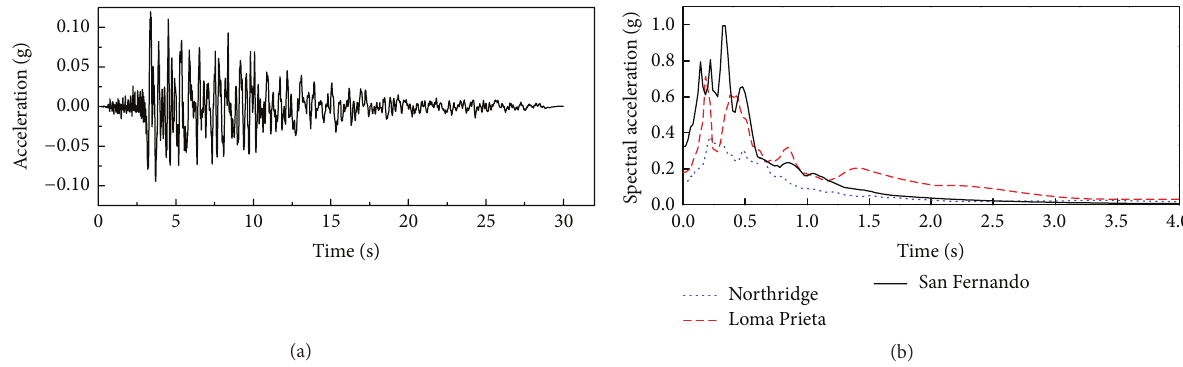
Figure 8: Earthquake record: (a) acceleration signal of the 1994 Northridge earthquake; (b) response spectra.